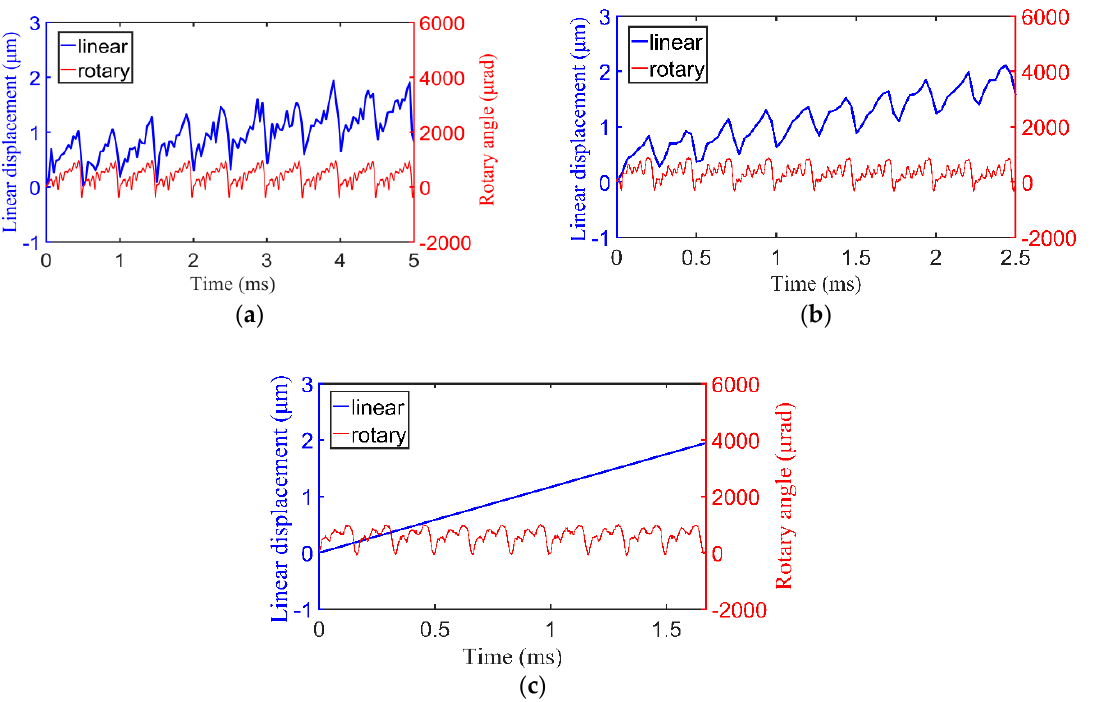
Figure 9. The output motions of the prototype motor under different driving frequencies: ( a ) 2 kHz; ( b ) 4 kHz; ( c ) 6 kHz.